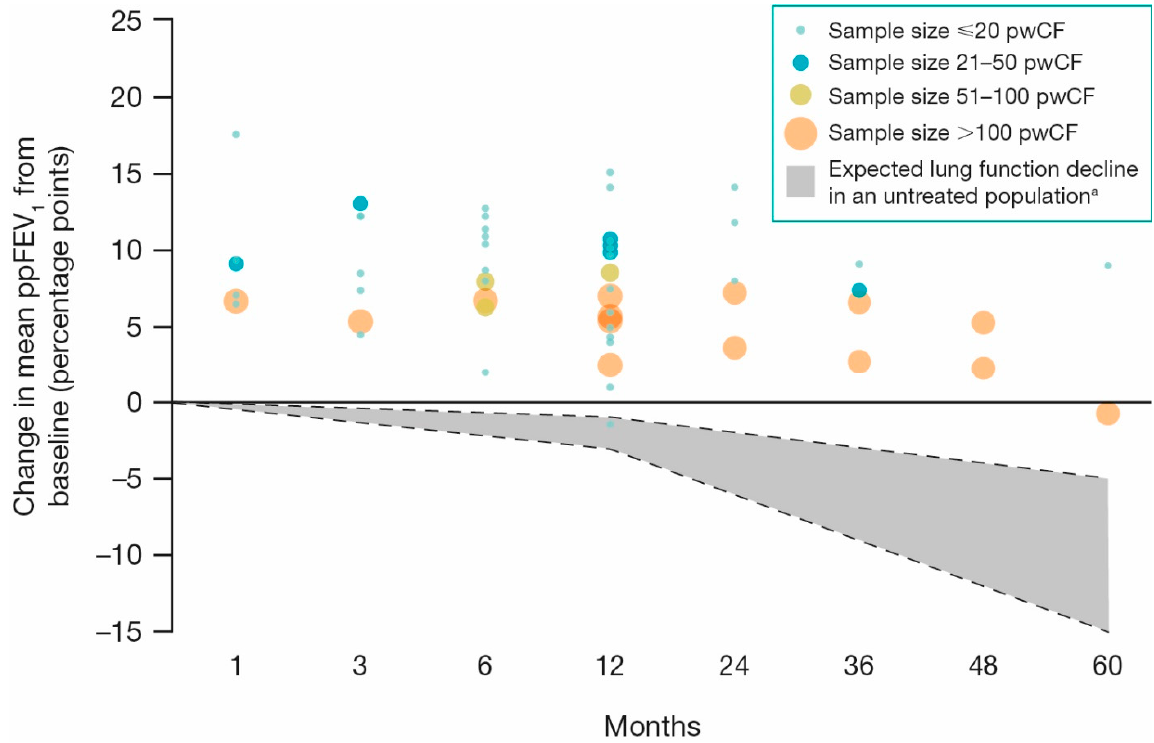
Figure 3. Change in mean ppFEV 1 with ivacaftor treatment (31 studies) [30,40–42,44,45,47,49,53,54,57,58,62,66,72–78,82,83,86,87,91–93,95,98,99]. Note: Figure only includes studies reporting absolute change from baseline within the ivacaftor-treated cohort in ppFEV 1 at 1, 3, 6, 12, 24, 36, 48, and/or 60 month time points following ivacaftor treatment. Excludes ppFEV 1 for pwCF with severe lung disease ( n = 3) [71,94,96]. a The grey area represents the range of ppFEV 1 decline in pwCF treated with standard therapies not including CFTR modulators, being between 1–3 percentage points annually, which, when extrapolated to 60 months, is in the range of 5–15 percentage points [4]. CFTR: cystic fibrosis transmembrane conductance regulator; ppFEV 1 : percent predicted forced expiratory volume in 1 s; pwCF: people with cystic fibrosis.